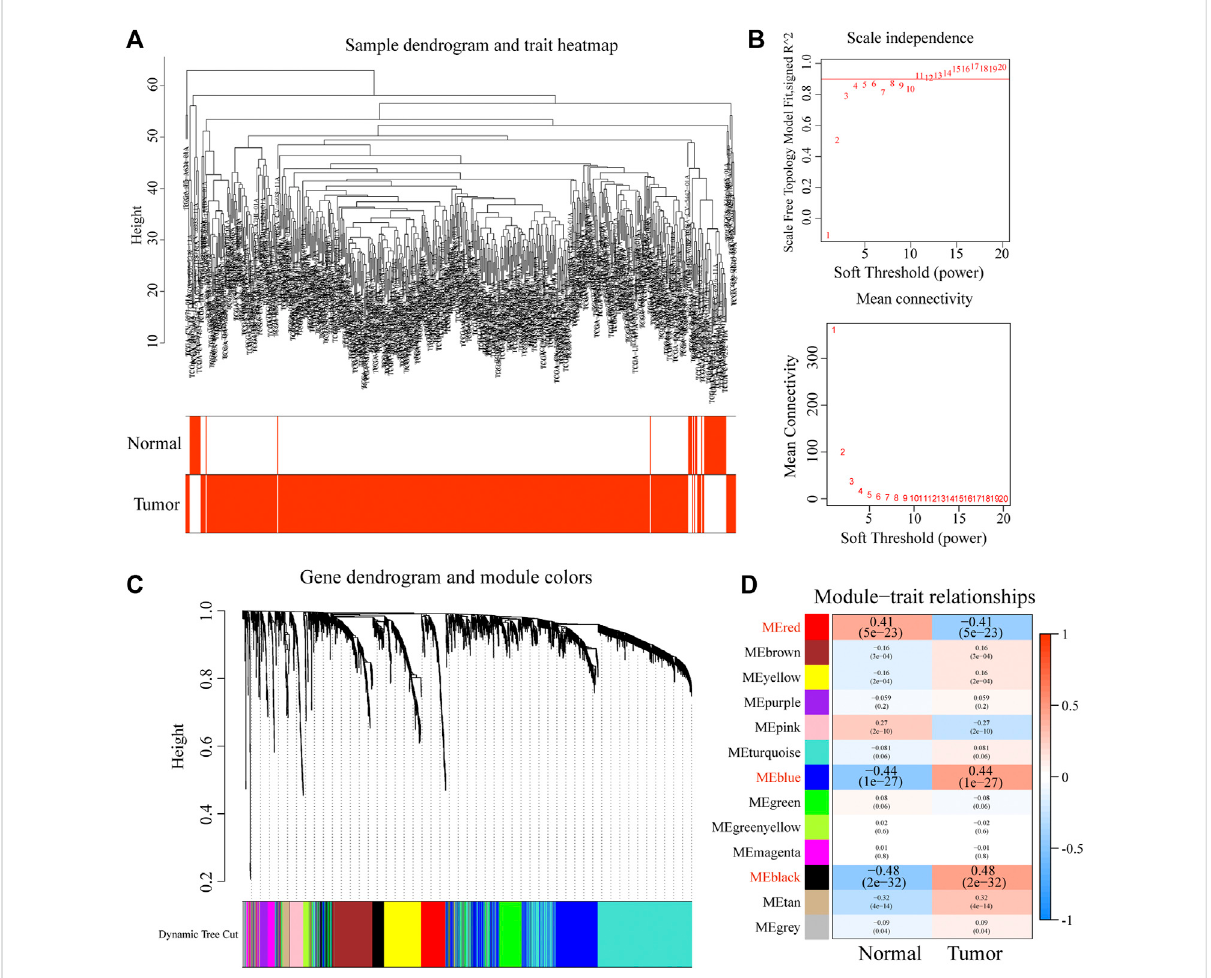
FIGURE 1 Construction of a co-expression network through WGCNA. (A) Clustering dendrogram of HNSCC samples. (B) Network topology for different soft-thresholding powers. (C) The cluster dendrogram of co-expression network modules is ordered by a hierarchical clustering of genes based on the 1-TOM matrix. (D) Module-trait